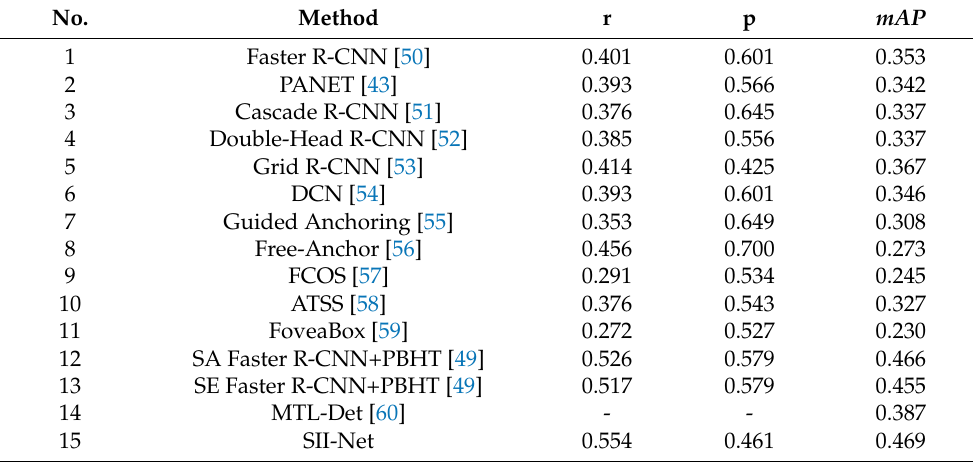
Table 4. Evaluation indices comparison with the other methods on LS-SSDD-v1.0 of the inshore